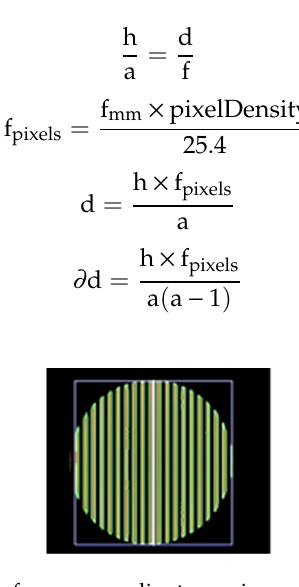
Figure 15. Reference coordinates on image sensor plane.